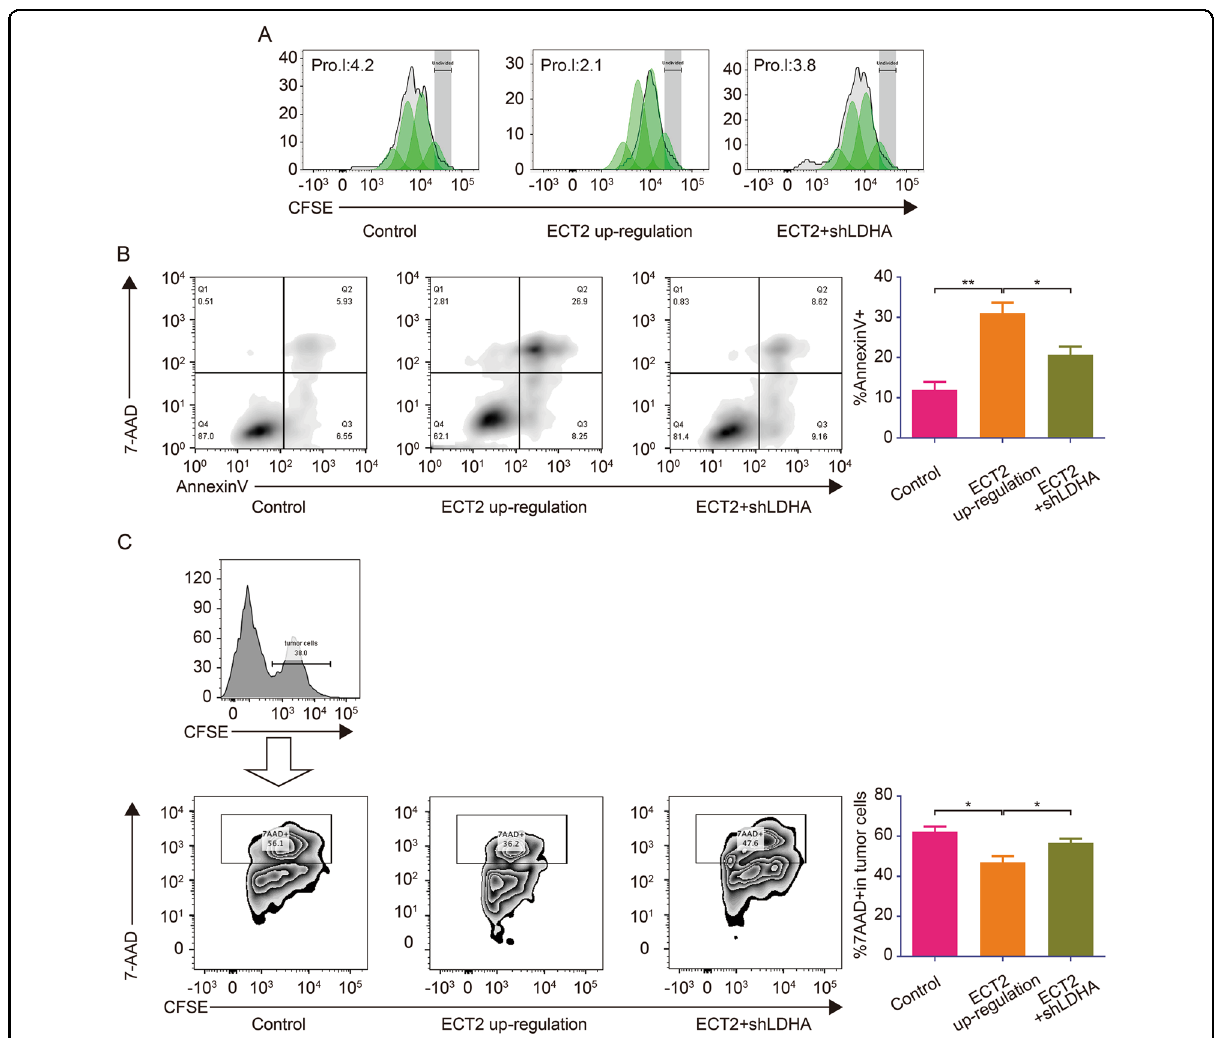
Fig. 7 ECT2 overexpression-induced macrophages impair immune cell function. A CFSE was used to evaluate the proliferation of T cells. T cells were cultured directly with macrophages, which were induced by cancer cells for 48 h. B T cells were cultured directly with macrophages, which were induced by cancer cells for 48 h. The apoptosis rate was evaluated by using Annexin V staining. C NK cell cytotoxicity assay was performed. NK cells were pre-co-cultured with macrophages, which were induced by cancer cells. HepG2 cells were used as target cells. The right panel shows the quanti fi cation of NK cell cytotoxicity. Error bars represent means ± SD. * p < 0.05, ** p < 0.01. NS means “ not signi fi cant ” by paired two-sided Student ’ s t